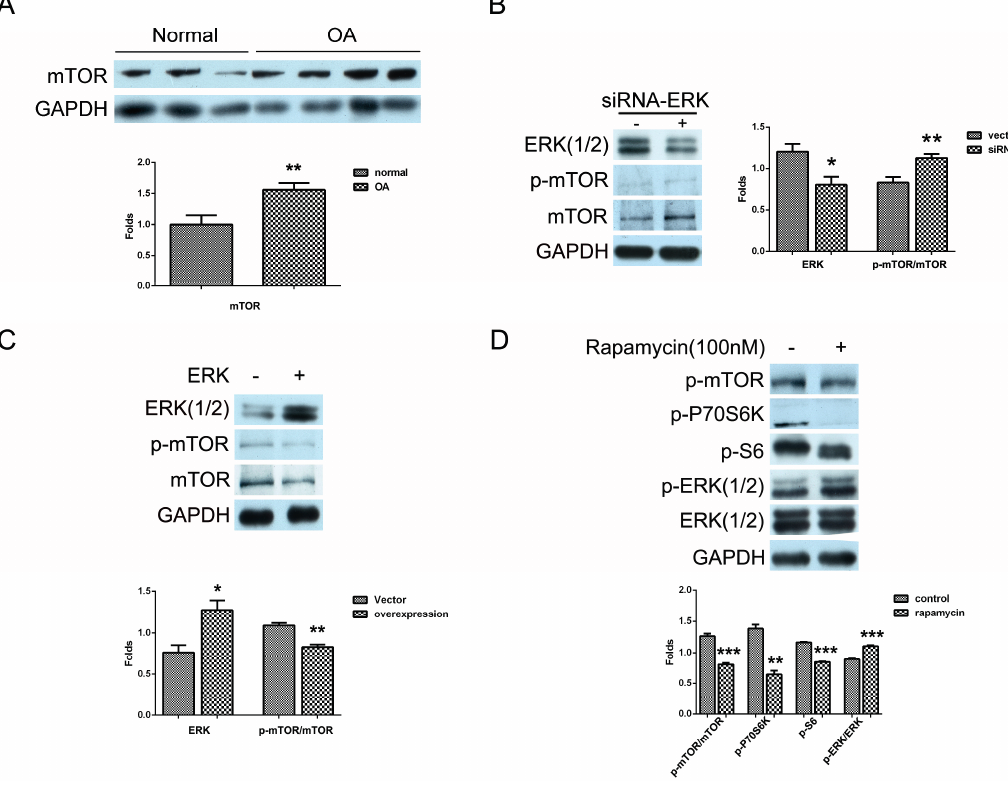
Figure 3. The mutual inhibition of mTOR and ERK in human OA chondrocytes. ( A ) Normal and OA chondrocytes were cultured, and the level of mTOR was detected by western blotting analysis using anti-mTOR, p-mTOR, and GAPDH antibodies; ( B ) Cells were transfected with siRNA/ERK vector for seven days and the levels of mTOR and p-mTOR were detected by Western blotting analysis using anti-mTOR, p-mTOR and GAPDH antibodies; ( C ) Cells were transfected with ERK vector for two days and the levels of mTOR and p-mTOR were measured with western blotting analysis; ( D ) Cells were treated with rapamycin (100 nM) for 2 h and the levels of p-mTOR, p-P70S6K, p-S6, ERK(1/2), and p-ERK(1/2) were detected by